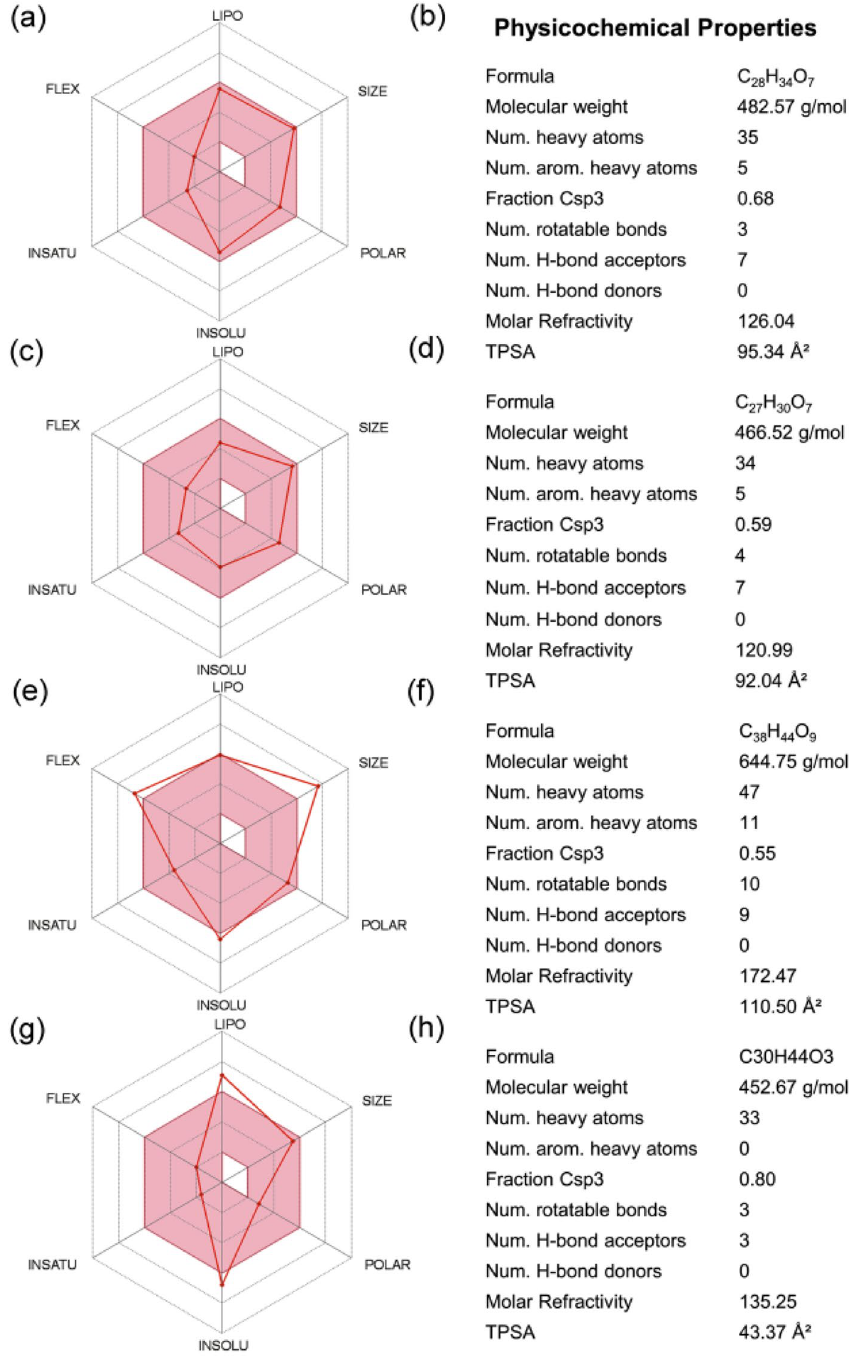
Figure 2. ADMET analysis for the selected bioflavonoids, i.e., ( a , b ) Gedunin, ( b , c ) Nimbolide, ( d , e ) Ohchinin acetate, and ( f , g ) Kulactone, as inhibitor against